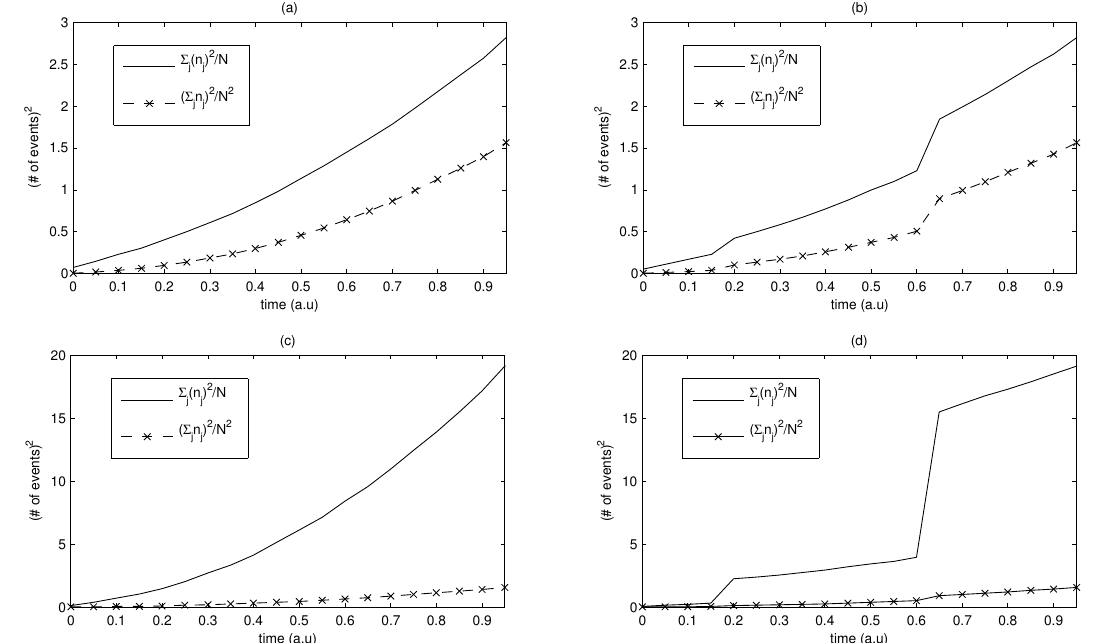
Fig. 1. Plot of the two terms in Eq. (3) for four different cases. Figure 1a represents the case with 10000 events randomly distributed in time and space, Fig. 1b obtained from clustering 600 and 1500 out of the 10000events at t = 0.2 and 0.7, respectively, Fig. 1c is obtained by clustering 600 and 1500 out of the 10000events spatially with the same latitudes and longitudes and Fig. 1d is obtained from the combination of the latter